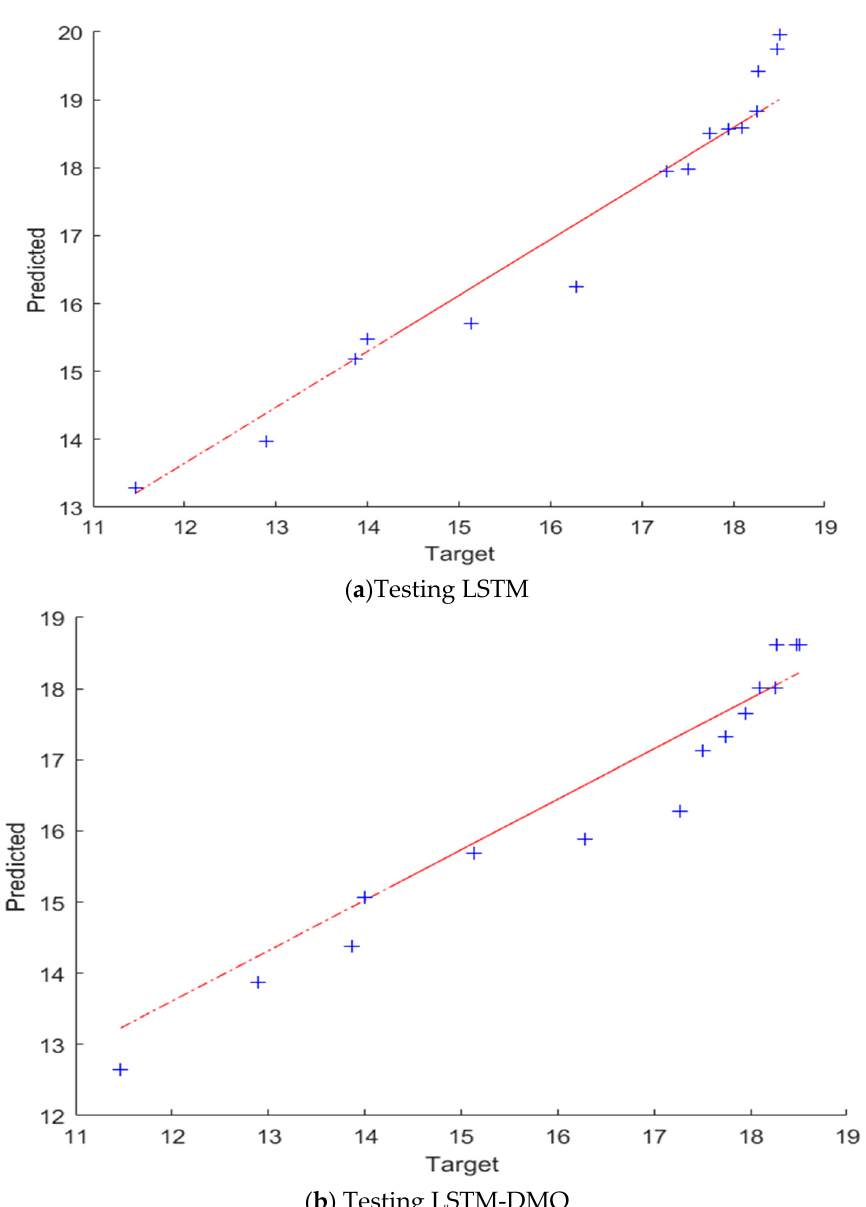
Figure 9. The QQ plots of the TEC and its prediction using LSTM, and LSTM–DMO. The predicted and target values refer to the model prediction and the experimental results of the coefficient of thermal expansion of Cu-Al 2 O 3